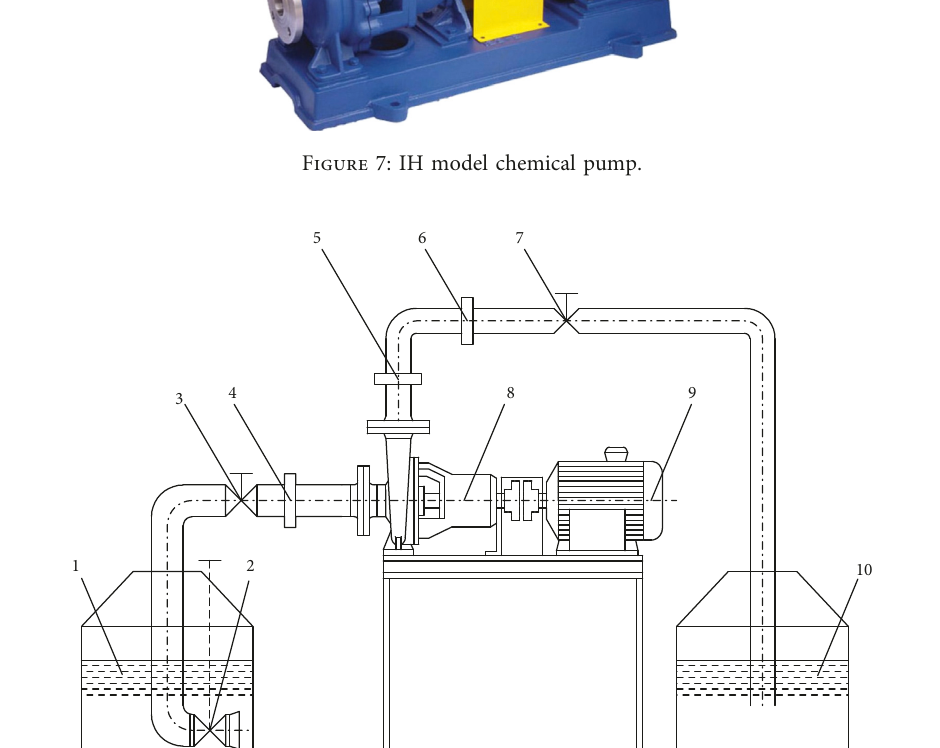
Figure 8: External characteristic test bench. (1) Water tank, (2) vacuum control valve, (3) inlet control valve, (4) vacuum table, (5) pressure gauge, (6) flow meter, (7) flow control valve, (8) test pump, (9) motor, and (10) water